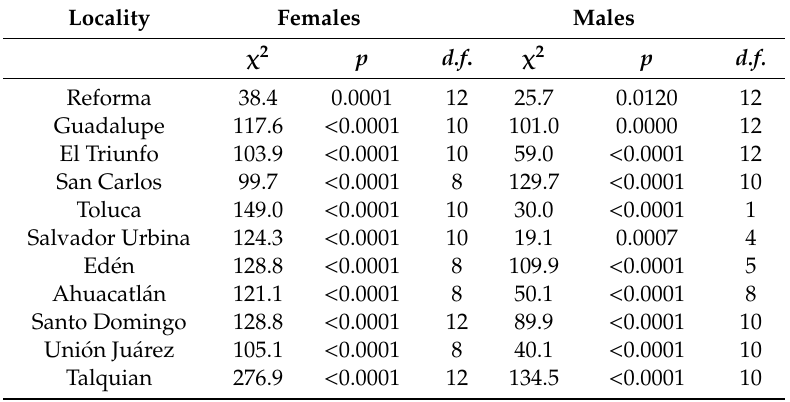
Table 3. Results of pooled Chi-square analyses of loci to test for Hardy–Weinberg equilibrium in Anastrepha ludens male and female samples collected at 11 localities of the Soconusco region in Chiapas, Mexico. The analysis of loci is shown in Table S1. (Supplement 01) d.f., degree of